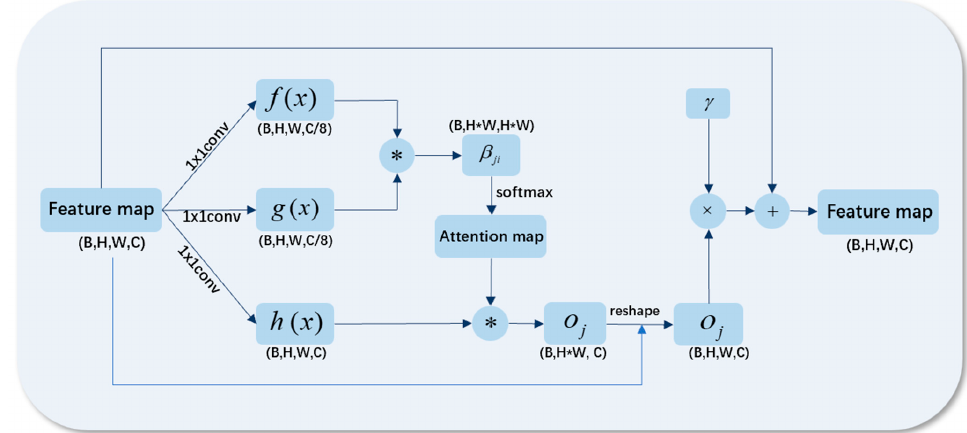
Figure 3. Schematic diagram of self-attention mechanism.